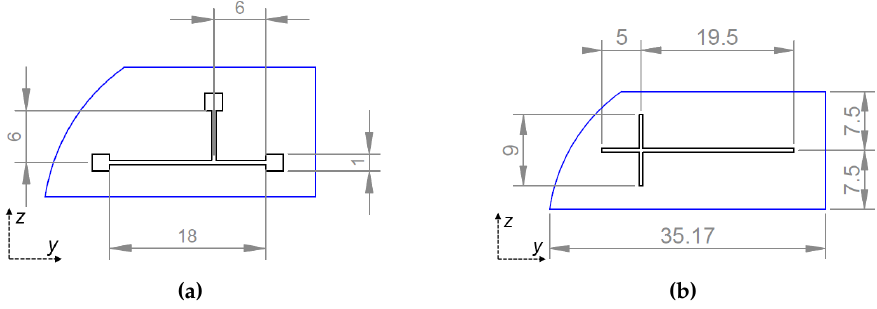
Figure 2. Schemes of the samples engraved with the laser ablation technique ( a ) and the dicing saw ( b ) from + x view. Quotes are expressed in millimetres. Curved edges are the round shape of the commercial wafer from which samples were